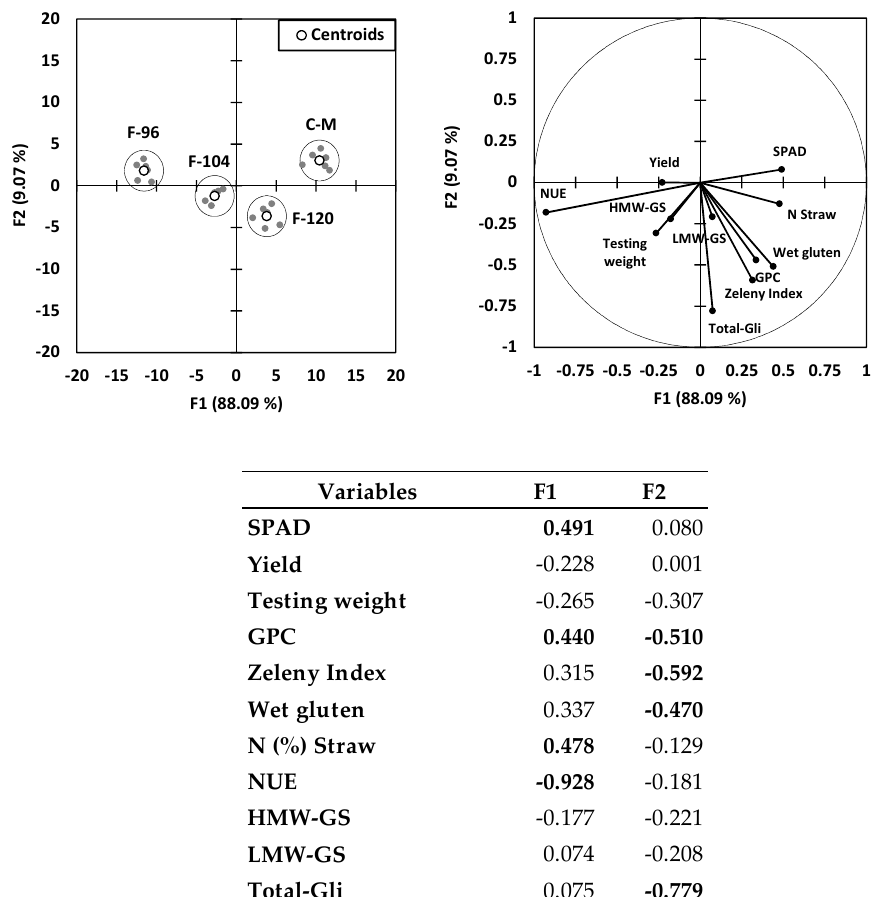
Figure 4. Principal component analysis (PCA; top right) with variable loadings (in bold > |0.4|; bottom) and multigroup discriminant analysis (MDA; top left) in wheat under different N fertilization treatments with urea as foliar fertilizer in two years. In MDA, circles contain 100% of cases.